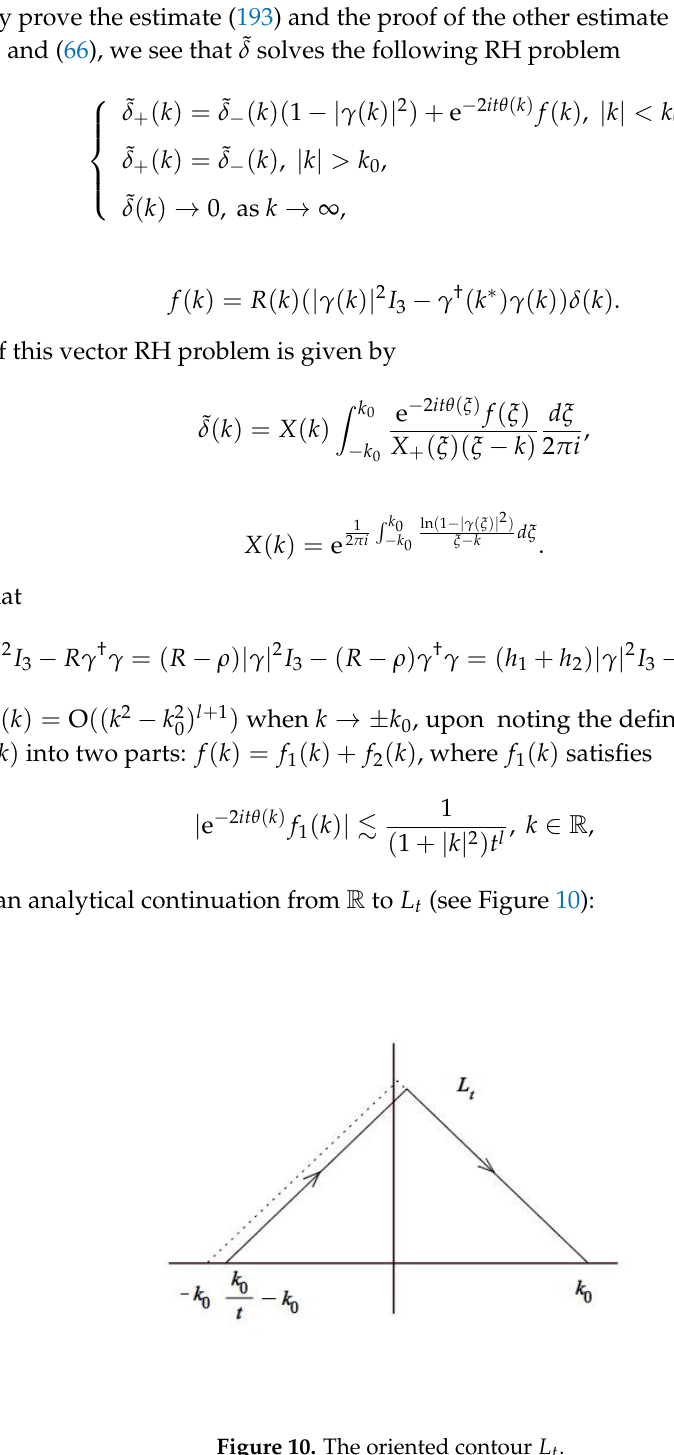
Figure 10. The oriented contour L t